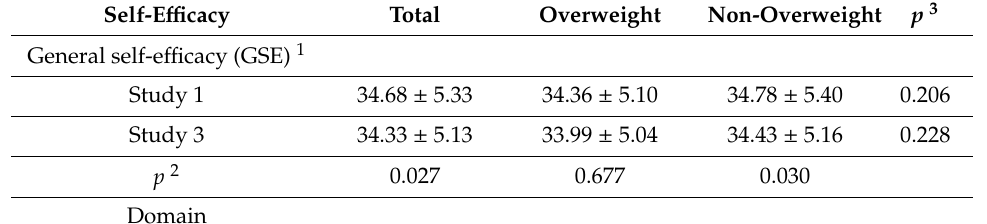
Table 4. Changes in the self-e ffi cacy before and after the Healthy Me program by the body weight status. Self-E ffi cacy